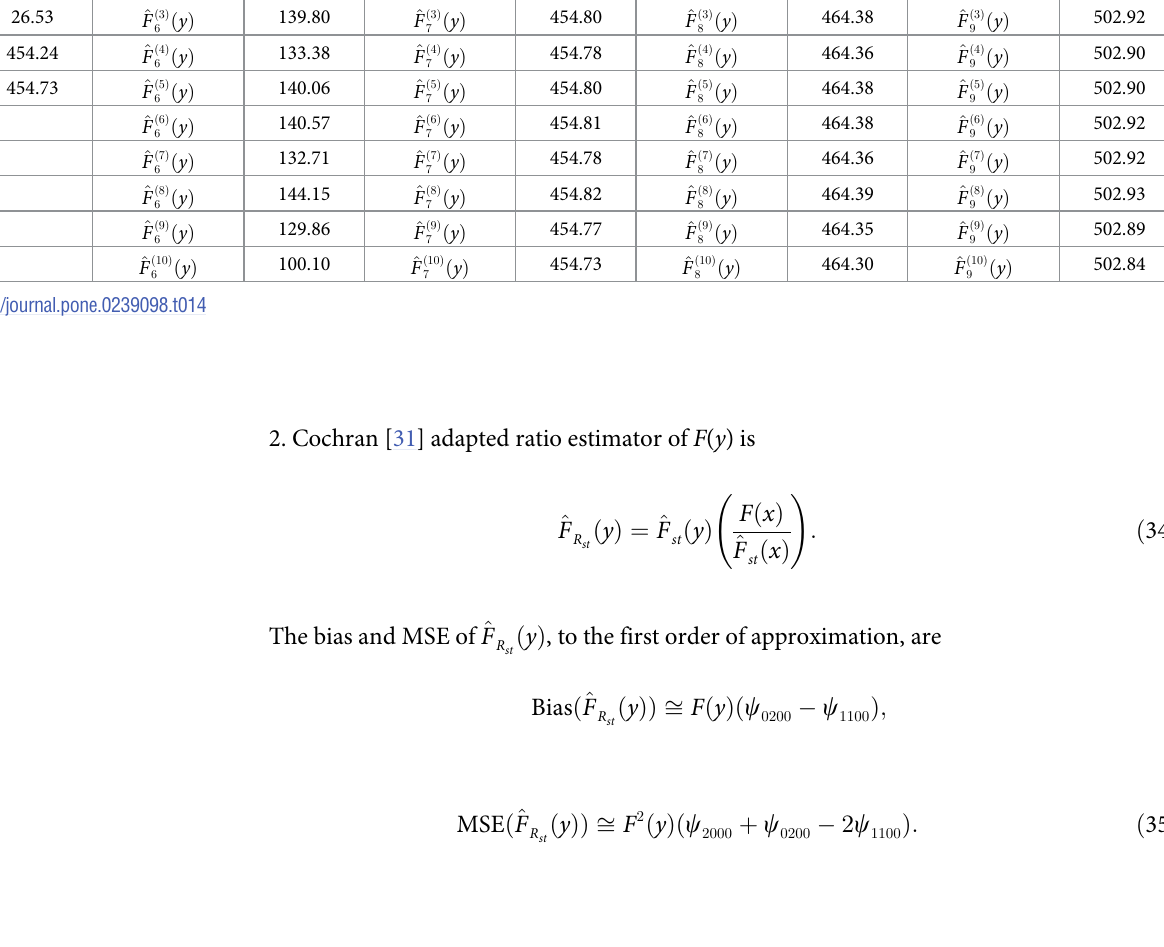
Table 15. PREs of distribution function estimators using Population